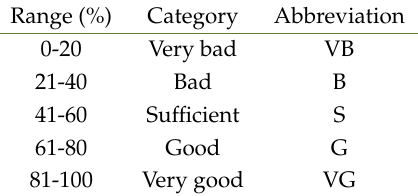
Table 4. Performance assessment scale.